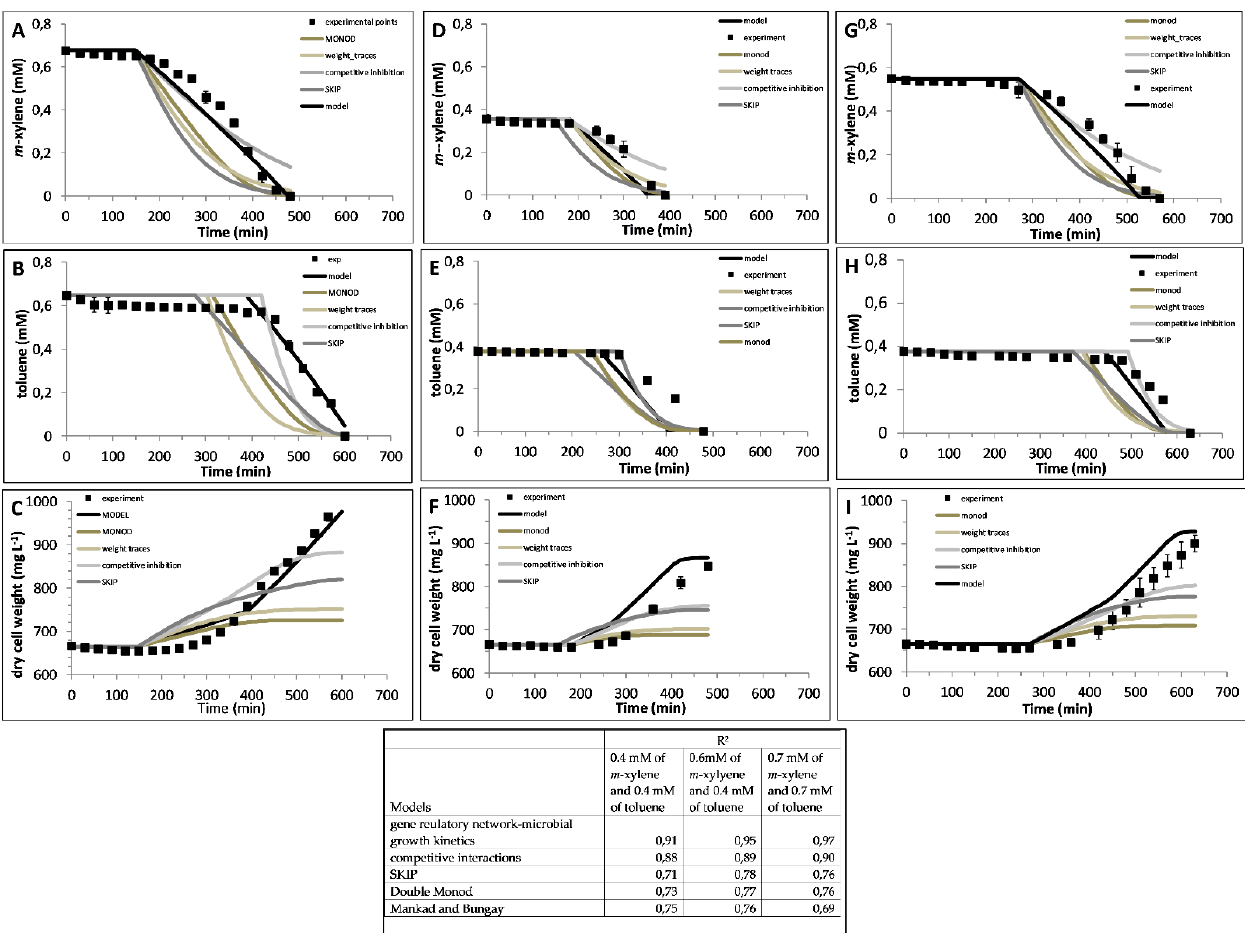
Figure 1. Comparison of the predictions of Tsipa et al. [11] framework with four commonly used microbial growth kinetic models for double substrate biodegradation. In the first experiment, 0.7 mM of both m -xylene ( A ) and toluene ( B ) were used, while microbial growth ( C ) was monitored. In the second experiment, 0.4 mM of both m -xylene ( D ) and toluene ( E ) were used, while microbial growth ( F ) was monitored. In the third experiment, 0.7 mM of m -xylene ( G ) and 0.4 mM of toluene ( H ) were used, while microbial growth ( I ) was monitored. R 2 was also determined for each model at each experimental condition, as shown in the Table. More details are discussed in Tsipa et al.